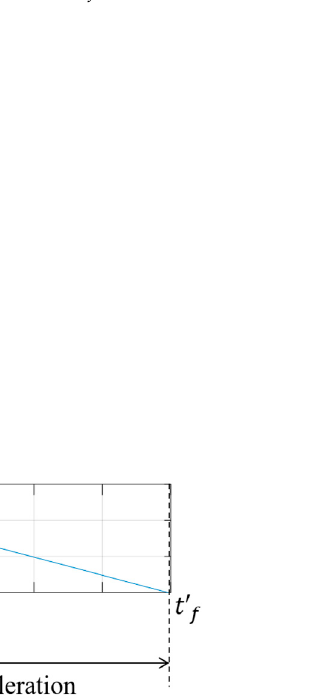
Figure 5. Short-pitch trapezoidal motion profile.